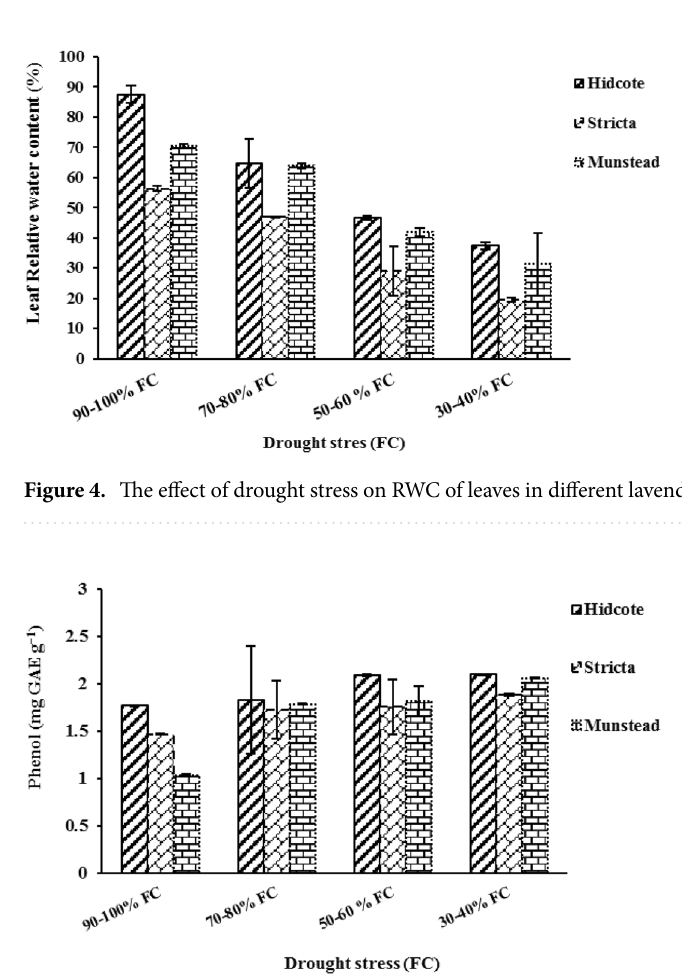
Figure 5. The effect of total phenolic content of leaves in different genotypes of